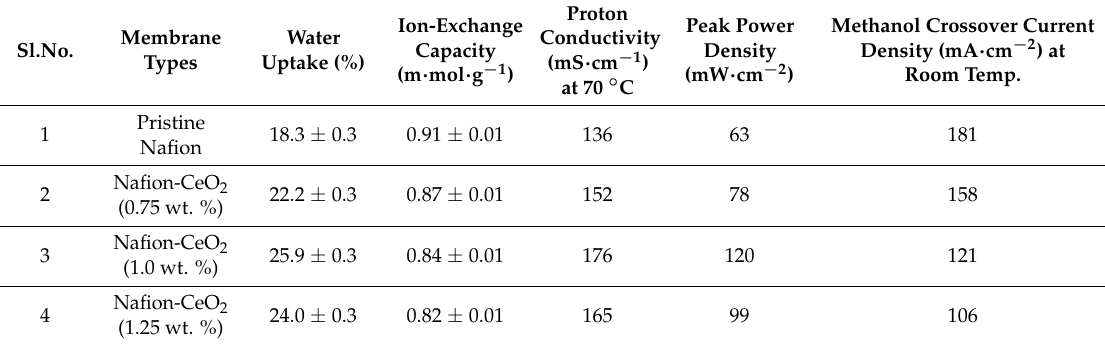
Table 1. Water uptake capacity, Ion-exchange capacity, proton conductivity, peak power density, methanol crossover current density of pristine Nafion and Nafion-CeO 2 Composite membranes.